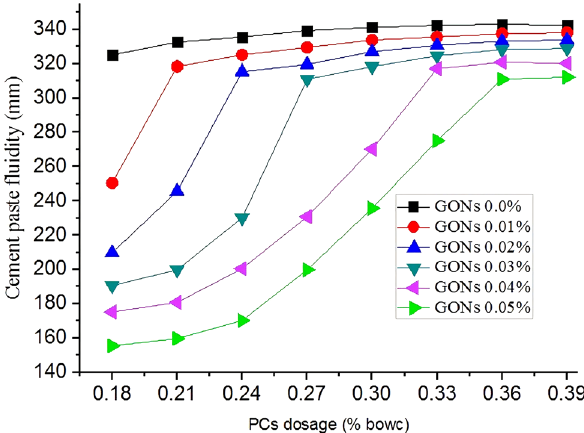
Figure 9: E ff ects of GONs and PCs on initial fl uidity [ 54 ]